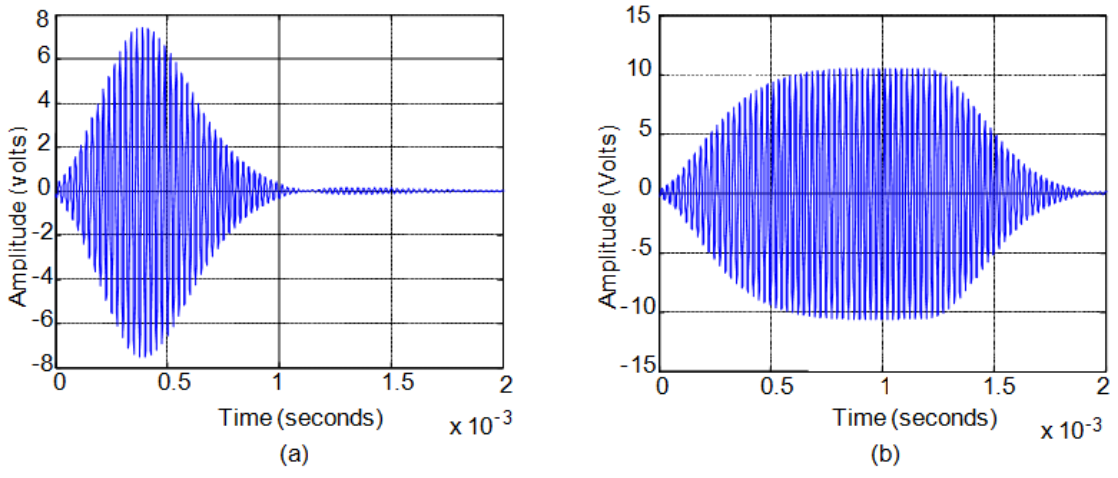
Figure 6. Echo generated for ( a ) short excitation pulse; ( b ) long excitation